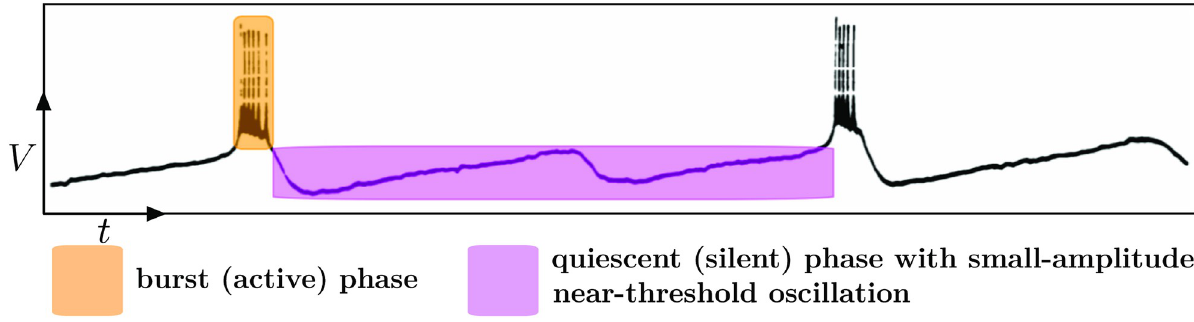
Fig 3. Electrophysiological recordings of the lateral thalamic nuclei neuron in cat from [31] show complex bursting oscillations. Colored boxes highlight the active (burst) and silent (quiescent) phases of the bursting oscillations. The quiescent phase comprises 1 oscillation formed by a slow rise toward bursting threshold and a faster descent toward baseline. This complex bursting pattern is well captured by the “Folded-node/Homoclinic” bursting scenario proposed here. Figure adapted with permission .